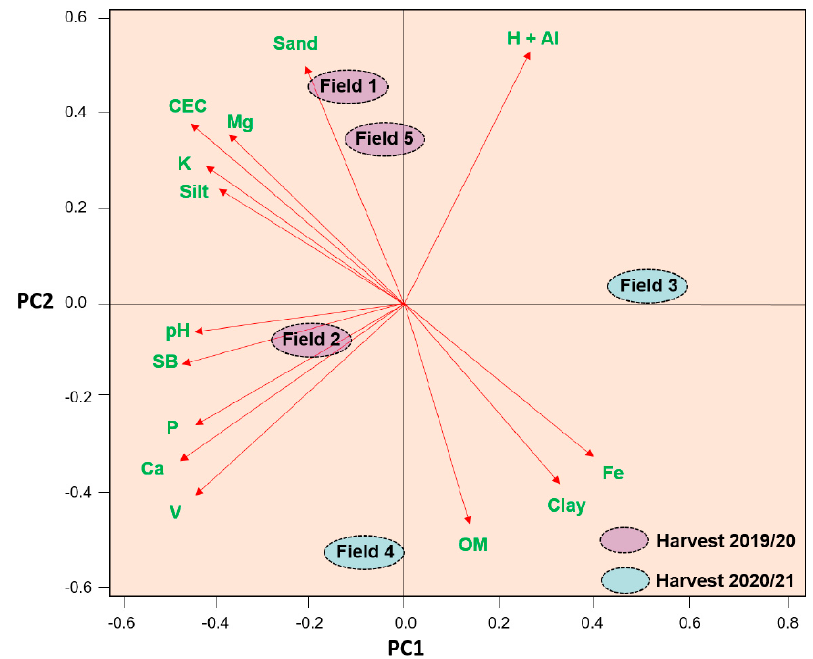
Figure 2. Principal component analysis of the relationship among soil attributes of five experi- mental fields in the interior of the state of Goiás, Brazil, evaluated for the cultivation of Glycine max L. in summer crops of 2019/2020 and 2020/2021. These fields had different histories of soybean cultivation. Field 1, soybean production for 30 years; Field 2, soybean production for 15 years; Field 3, soybean production for 10 years; Field 4, second year of soybean cultivation; Field 5, first year of soybean cultivation. OM, organic matter; CEC, cation exchange capacity; SB, sum of bases; V, base saturation (%); and H + Al, potential acidity.